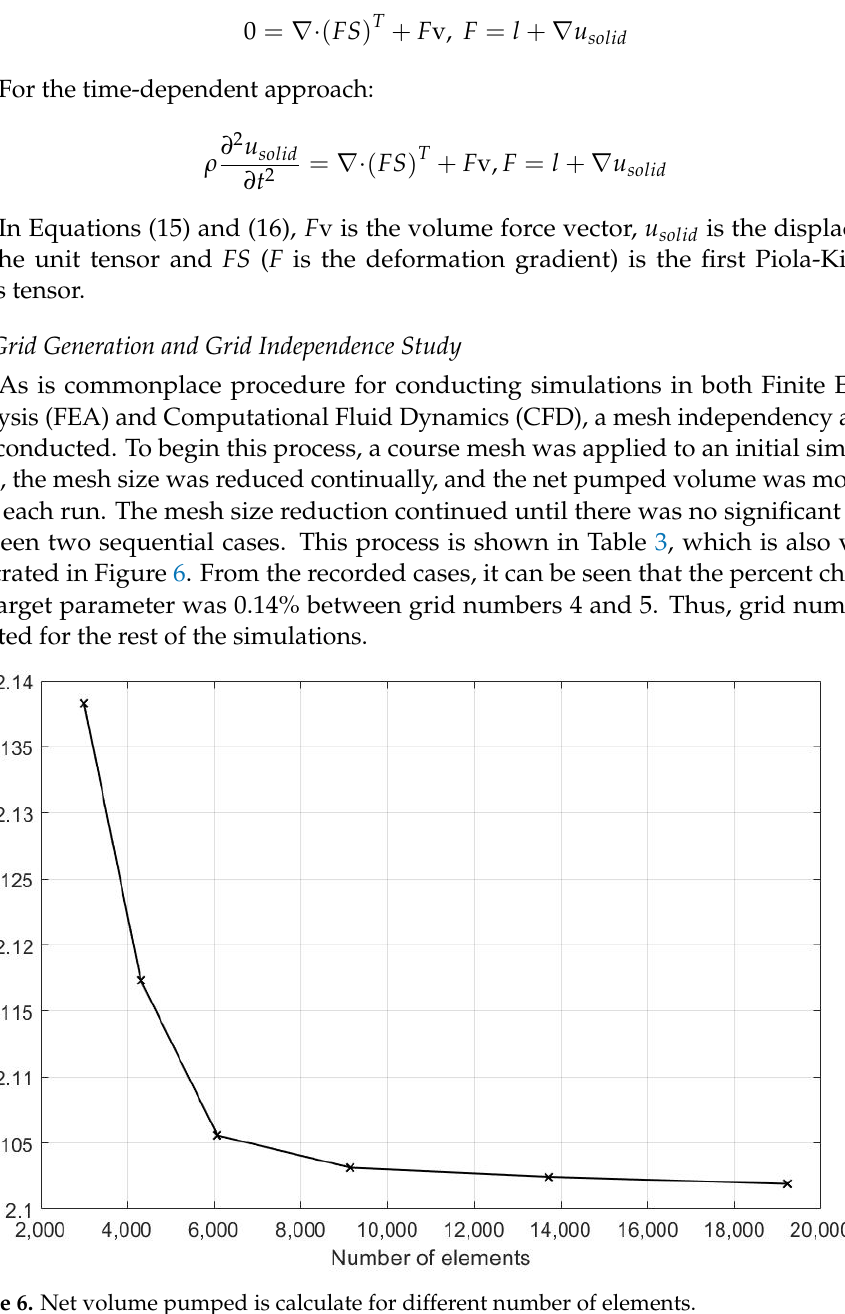
Figure 6. Net volume pumped is calculate for different number of elements.